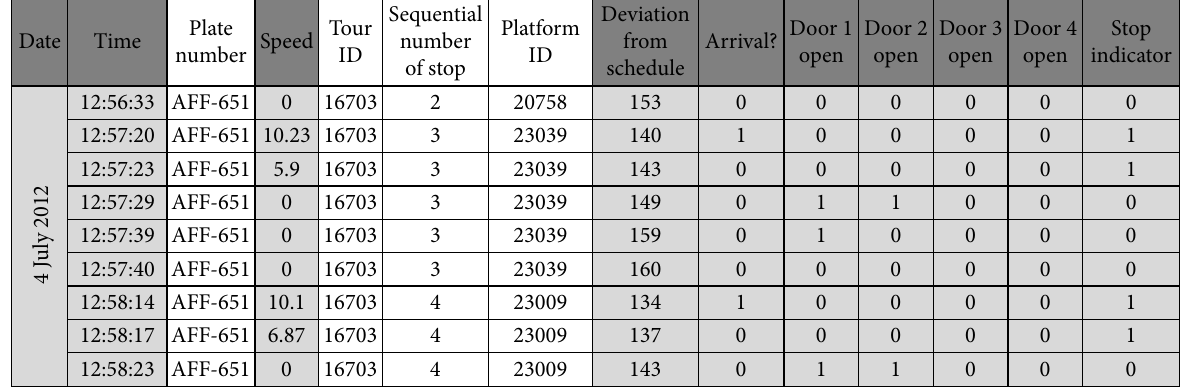
Table 3. Structure of data recorded by the vehicle tracking